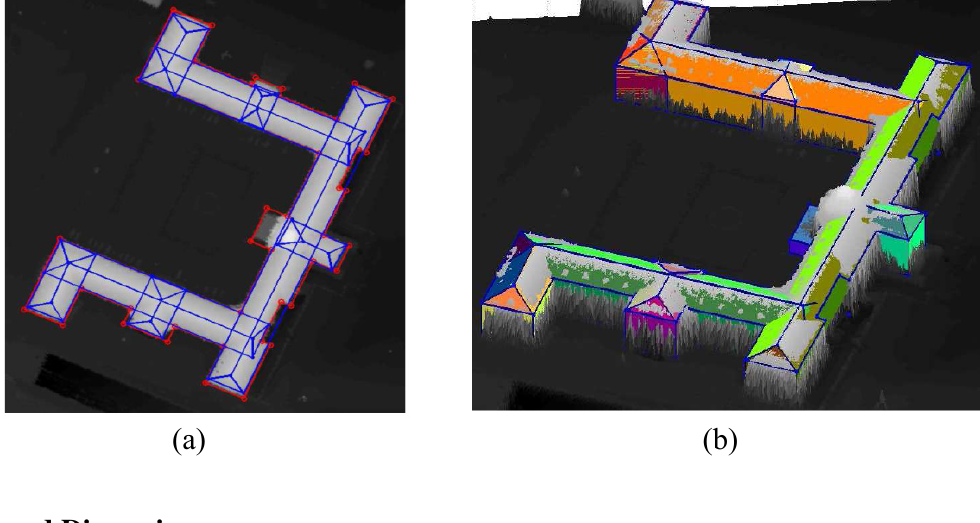
Figure 15. Generating the final 3D model of a building containing parametric and prismatic roof structures. ( a ) MBR-based approximation (red) and parametric models (blue); ( b ) Merged parametric and prismatic